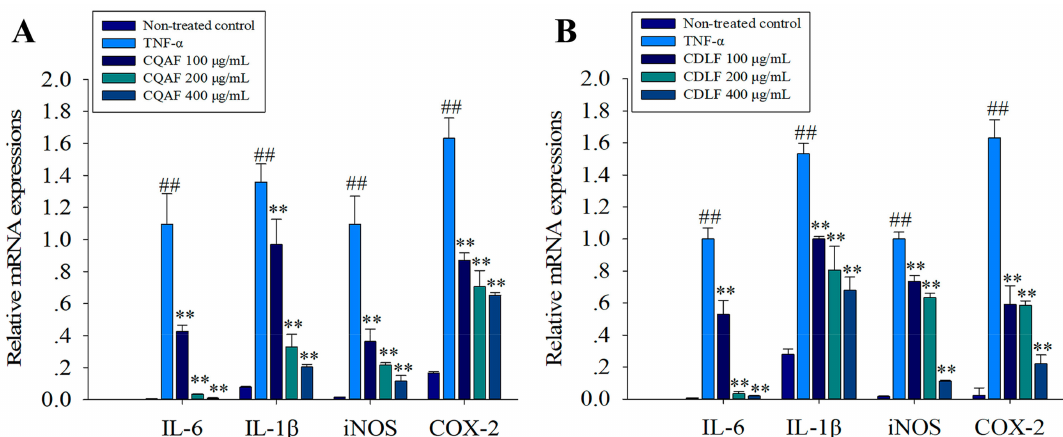
Figure 6. Effects of CDLF and CQAF on the mRNA expressions of IL-1 β , IL-6 , iNOS , and COX-2 in MH7A cells. The cells were treated with CDLF or CQAF at various concentrations (100–400 µ g/mL) for 24 h in the presence of TNF- α (50 ng/mL). GAPDH was used as the internal control. ( A ) CQAF treatment; ( B ) CDLF treatment. The data are presented as the mean ± SD ( n = 3). ## p < 0.01 when compared with the non-treated control group; ** p < 0.01 when compared with the TNF- α group. Numeric data can be found in Supplementary Materials Tables S5 and